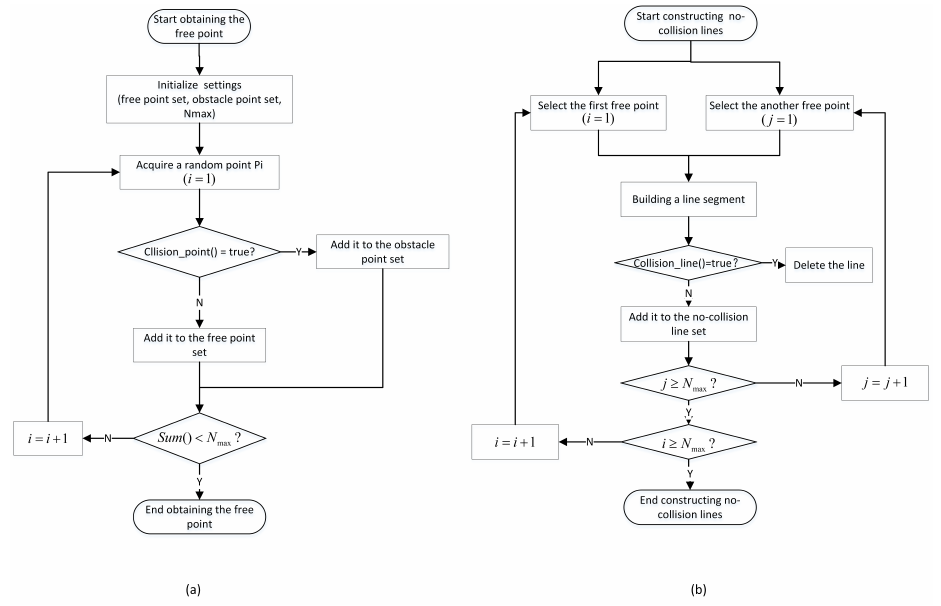
Figure 1. The learning process of typical PRM algorithm: ( a ) Obtaining free points; and ( b ) construct- ing collision-free line